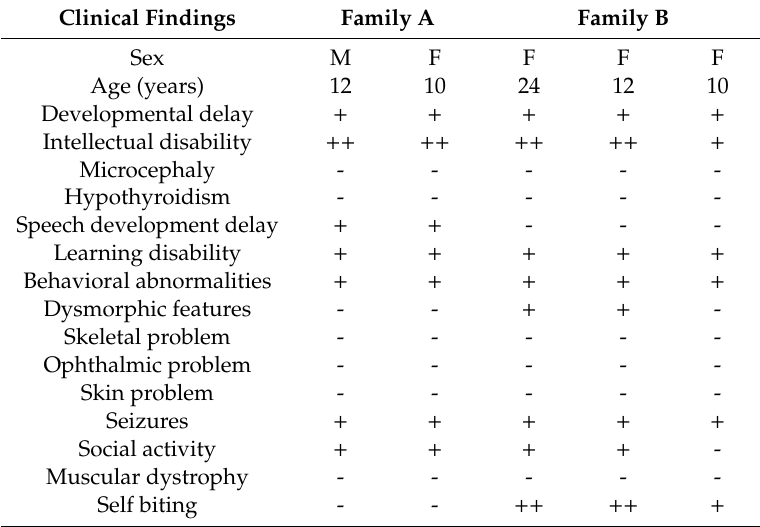
Table 1. Clinical information of families A and